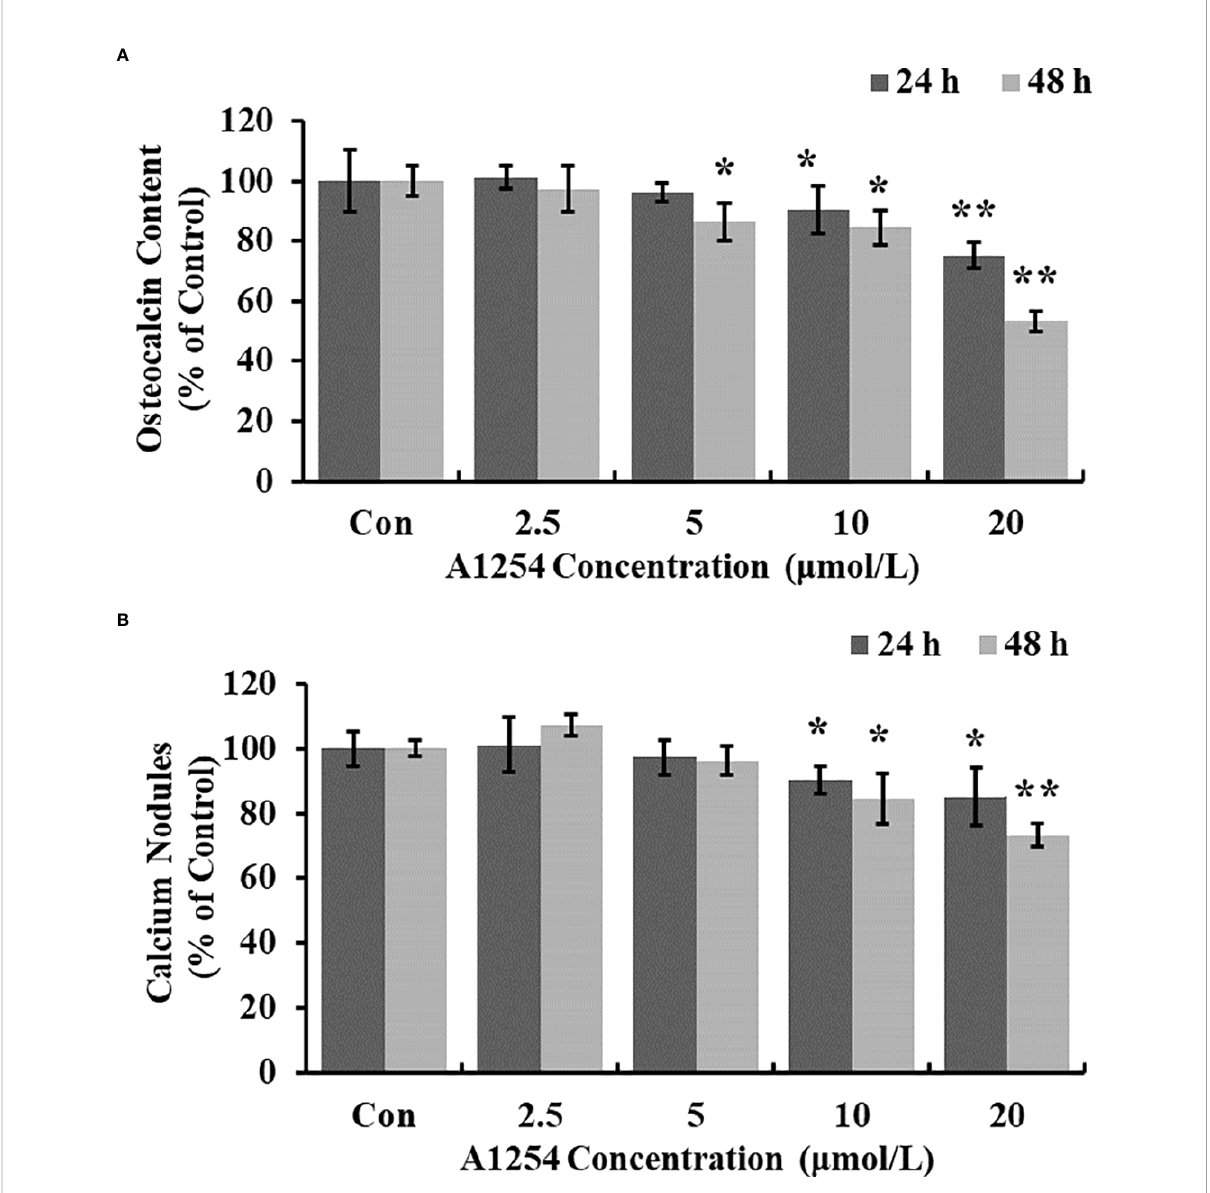
FIGURE 4 The osteocalcin content and calcium nodules formation in fl uenced by A1254. After exposure to various doses of A1254 for 24 and 48h, (A) The osteocalcin content in MC3T3-E1 cells was assessed with ELISA kit. (B) The calcium nodules formation was detected using Alizarin Red staining. The number of calcium nodules was counted, and nodules formation rate was calculated compared with the control group. *p<0.05, **p<0.01 compared to the